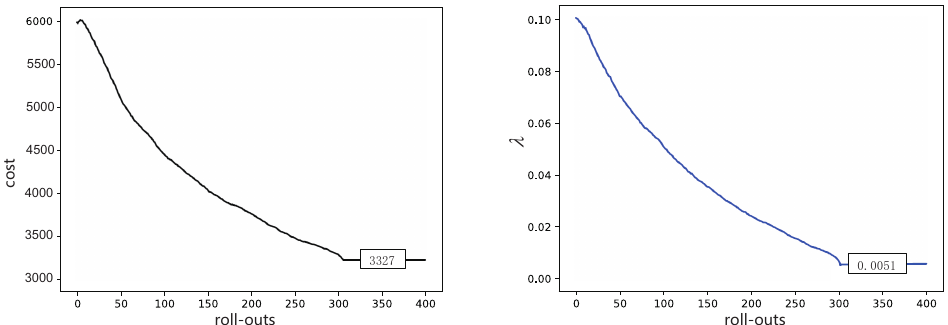
Figure 4. Learning curve for obstacle avoidance. Left: cost profiles with roll-outs. Right: the potential strength λ profiles with